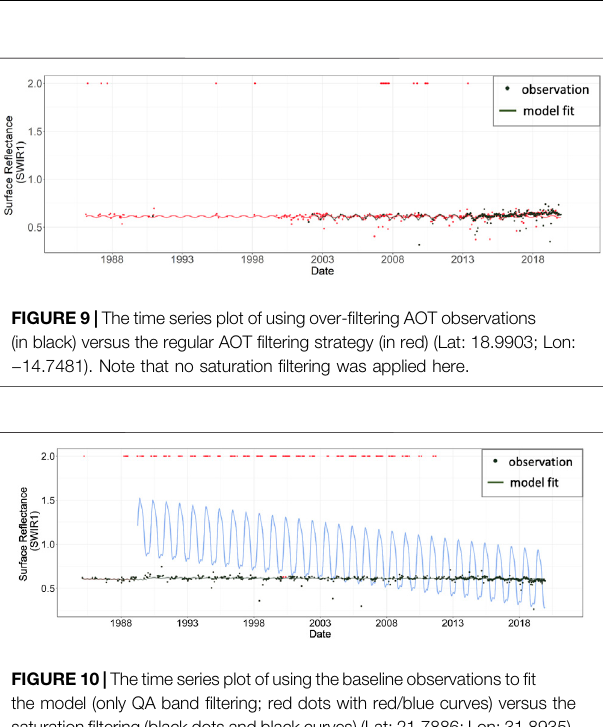
Frontiers in Remote Sensing |